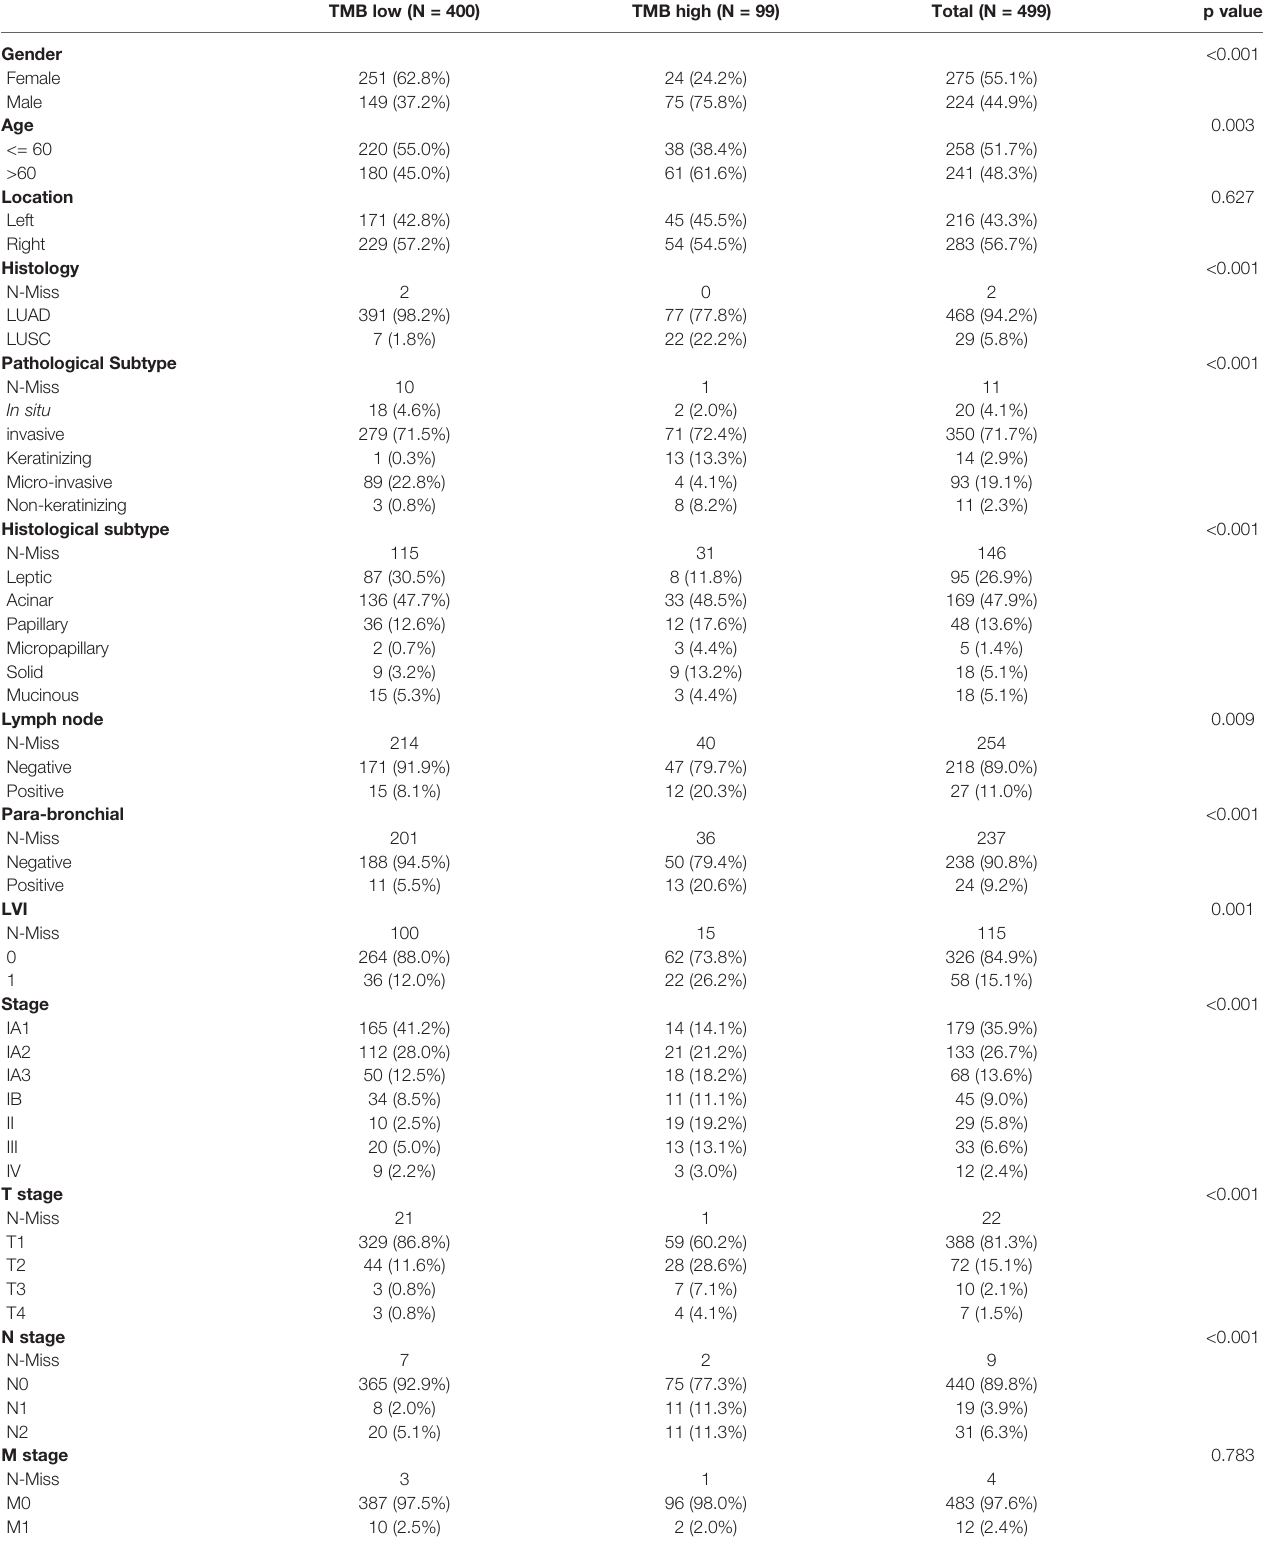
TABLE 1 | Baseline characteristics of included patients by